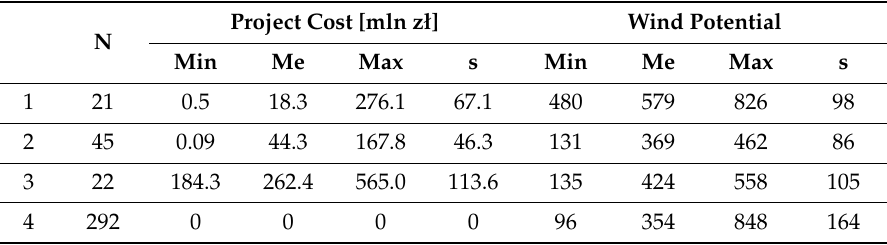
Table 3. Descriptive statistics for wind energy clusters.